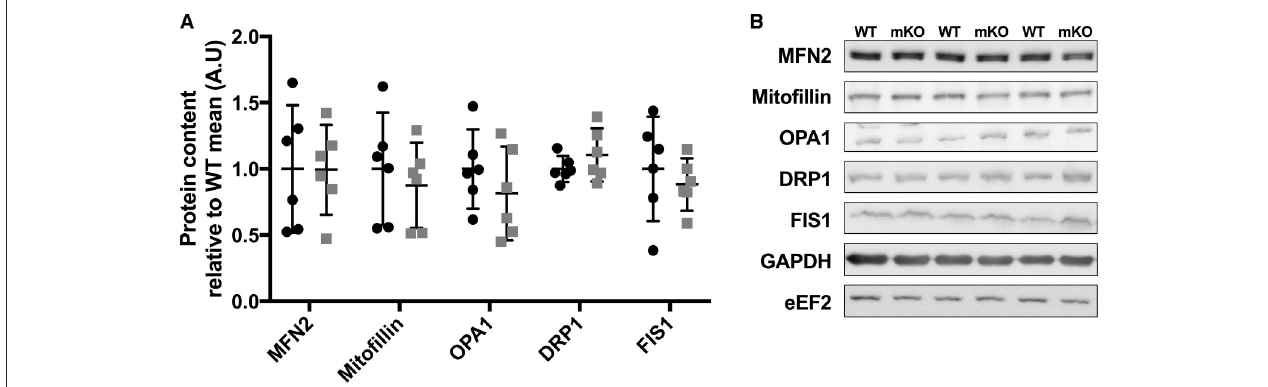
FIGURE 3 | Proteins controlling mitochondrial morphology are unchanged in p53 mKO (grey squares) compared to WT (black circles) mice. (A) WT and p53 mKO mice display similar content of proteins regulating mitochondrial fusion (MFN2, mitofillin, OPA1) and fission (DRP1 and FIS1) in gastrocnemius muscle ( p > 0.05; n = 6 per group). Similar data is apparent in triceps and quadriceps muscle (data not shown). (B) Representative immunoblot images.